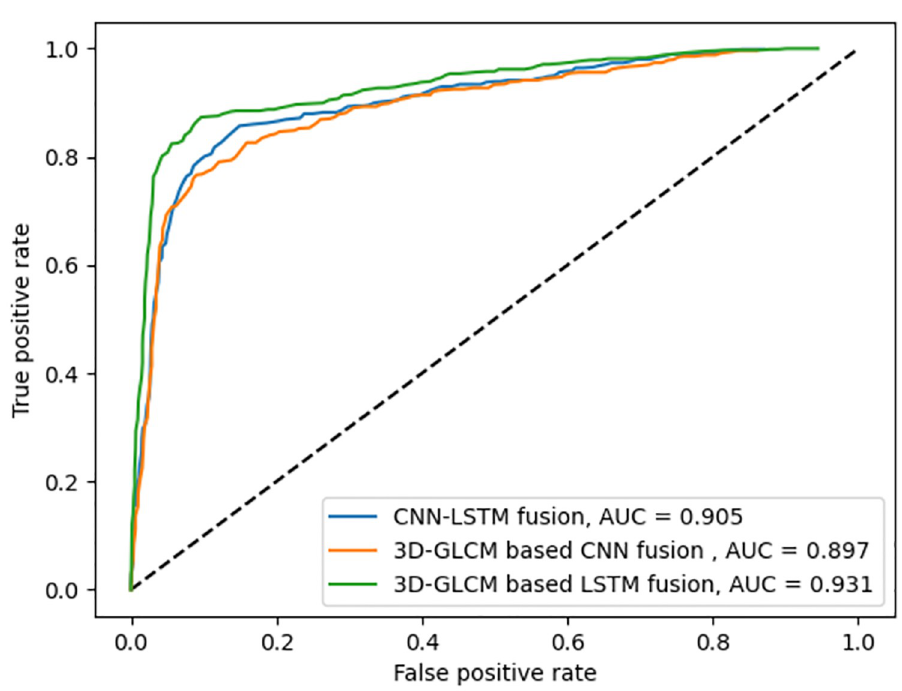
Fig 9. ROC curves for baseline and proposed models, and their corresponding micro-averaged AUC